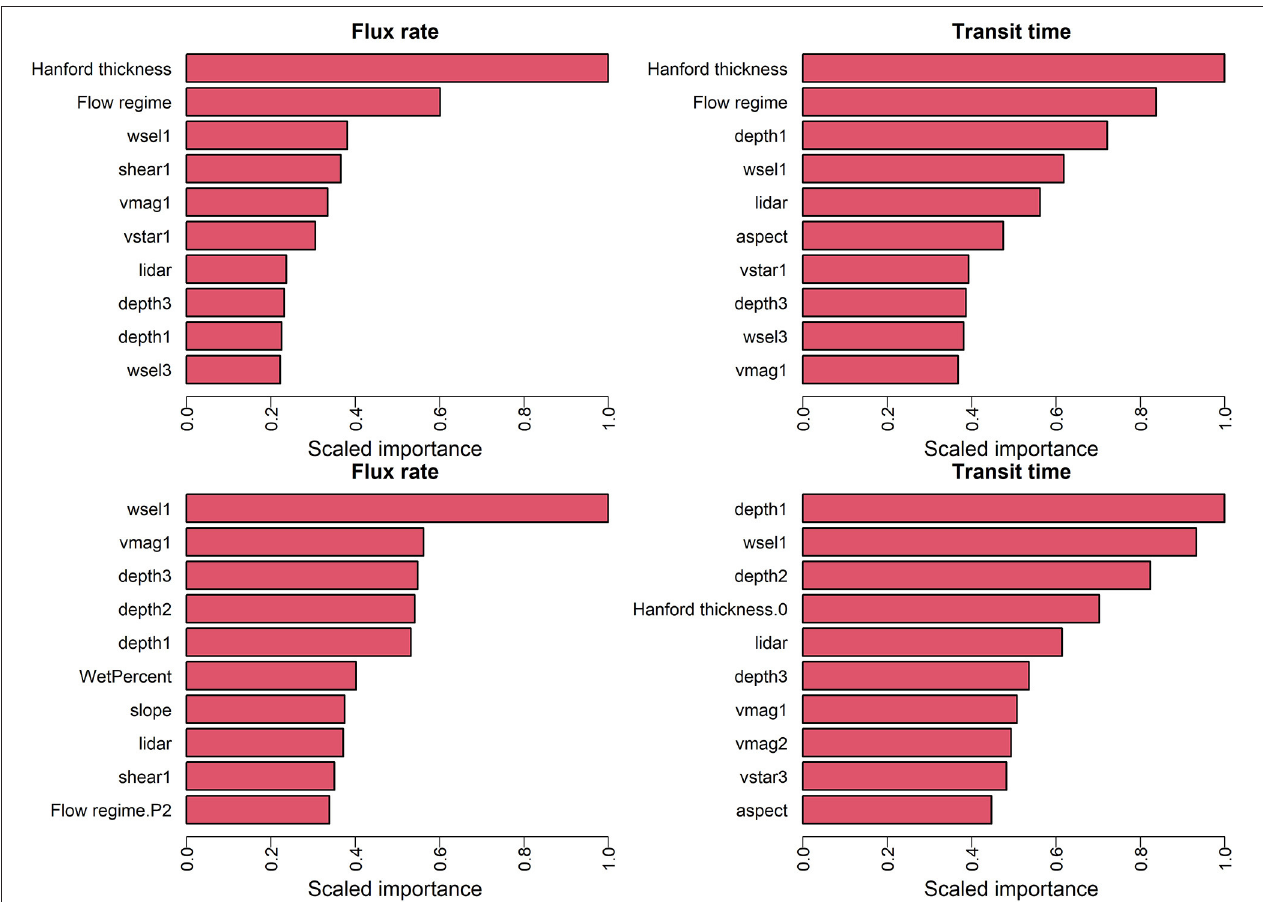
FIGURE 6 | Top 10 variables in terms of scaled feature importance for the optimally trained ML model trained, for prediction of flux (left) and transit time (right). The top panel is based on RF models and the bottom panel is based on XGB models.